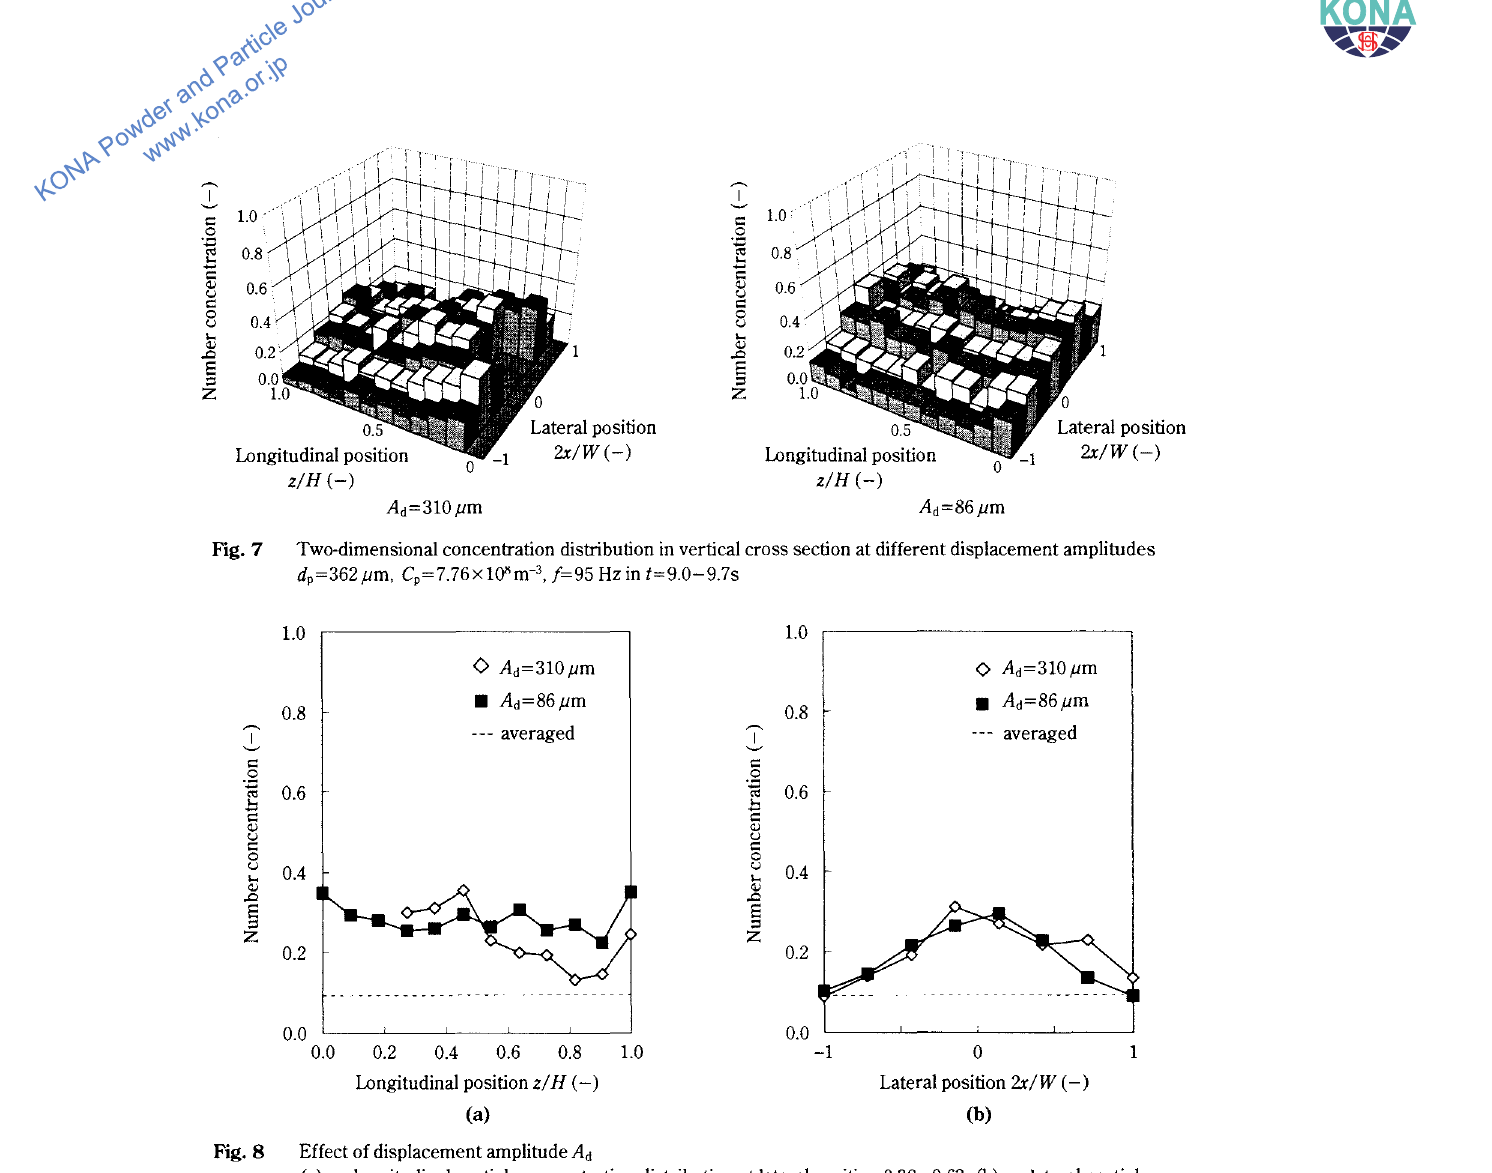
Fig. 7 Two-dimensional concentration distribution in vertical cross section at different displacement amplitudes dp=362 ,urn, Cp=7.76x10"m· 3, /=95Hz in t=9.0-9.7s